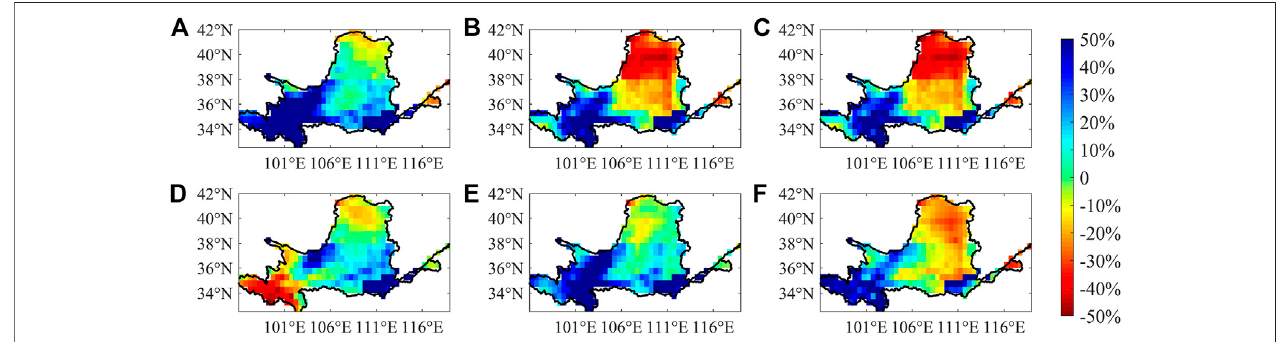
FIGURE9| DeviationofthespatialdistributionoftheaverageannualprecipitationintheYellowRiverBasinsimulatedbysixhigher-scoringGCMs.Panels (A – F) are ACCESS-CM2, CNRM-CM6 -1, CNRM-ESM2-1, FGOALS-f3-L, MPI-ESM1-2-HR,